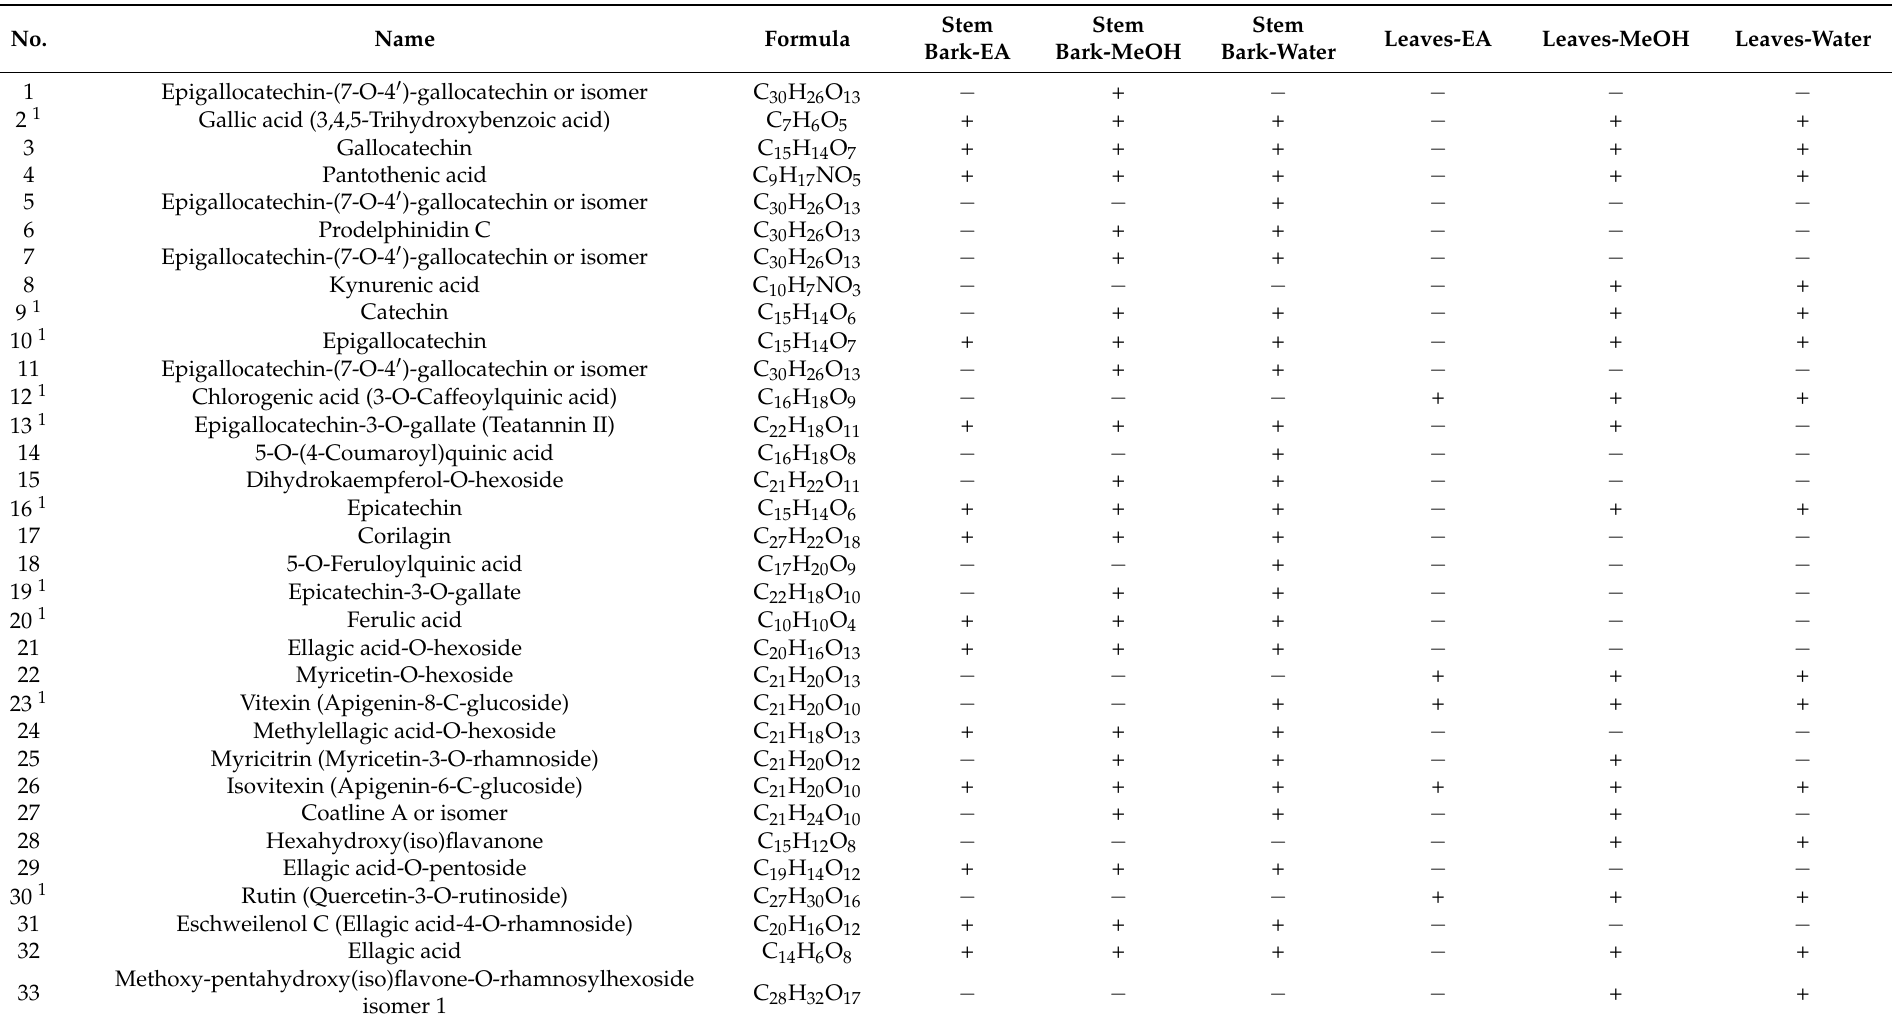
Table 2. Chemical composition of B. ferruginea